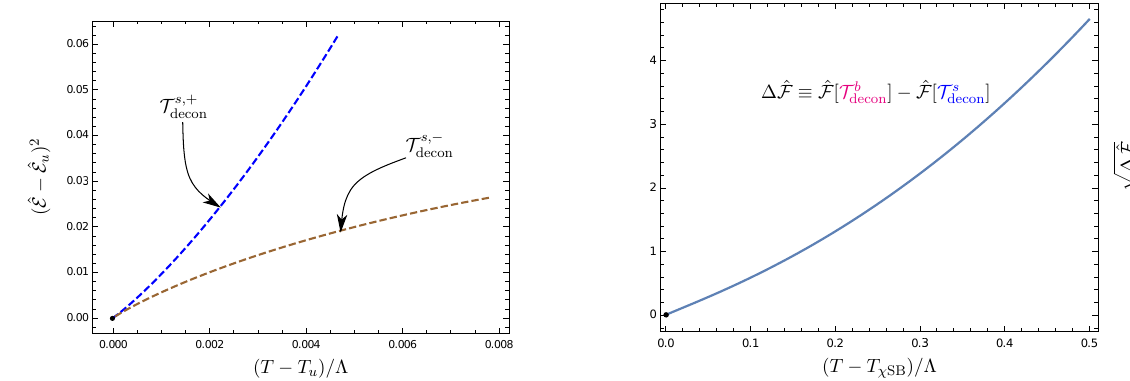
Figure 19 . Critical behavior at T = T u (the left panel) and T = T χ SB (the right panel). In the former case, the specific heat of The scaling of the free energy density difference between the two phase as T the phase transition at T = T χ SB is of the second